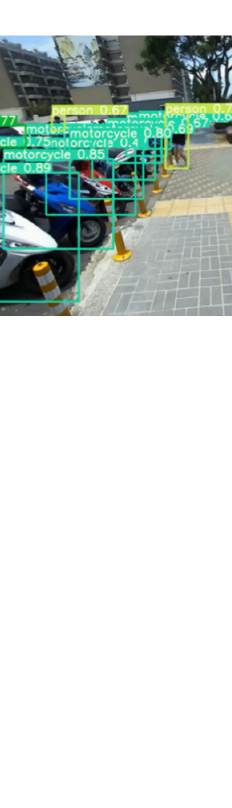
Table 7. The performance of YOLOv5s.